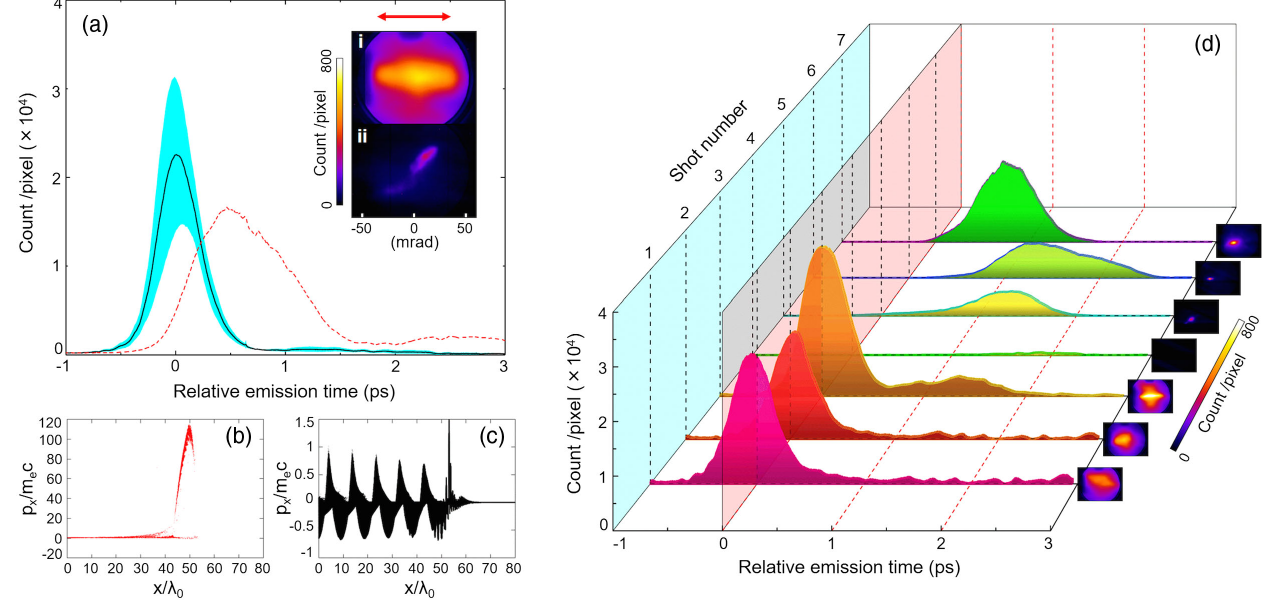
FIG. 5. Relative zero timing determination. (a) The black curve illustrates the mean value from statistics of 28 EO signals from N 2 gas for plasma densities from 1.2 to 2 . 3 × 10 19 cm − 3 . The samples include the signals in the blue zone in Fig. 4. The shadow in cyan color denotes the standard deviation. The inset (i) in (a) shows the typical electron beam profiles of the shots sampled for zero timing determination. The red double arrow denotes the laser polarization direction. The red dashed curve in (a) is a line out of an EO signal with later timing with its electron profile shown in the inset (ii). (b) and (c) are the ( x; p ) phase space plots of the electrons ionized from x the K-shell and L-shell of the N 2 atoms, respectively, from a PIC simulation at a laser propagation time of 5.3 ps. (d) is a water fall plot of 7 consecutive shots of EO signals at the beginning of the experiment when using pure He gas. The corresponding electron beam profiles are listed to the